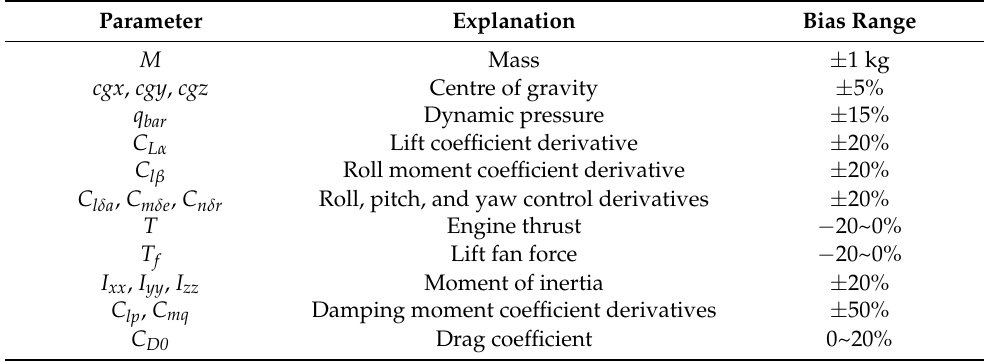
Table 5. Model parameters bias.